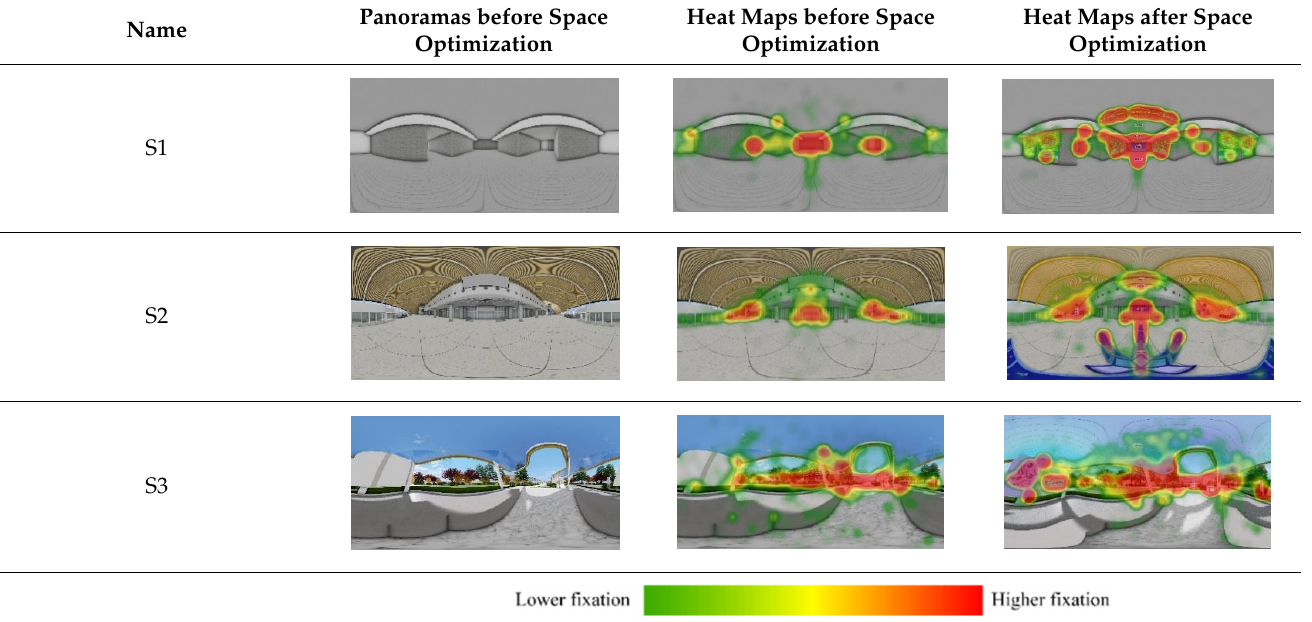
Table 9. Comparison of Heat Maps before and after Optimization.